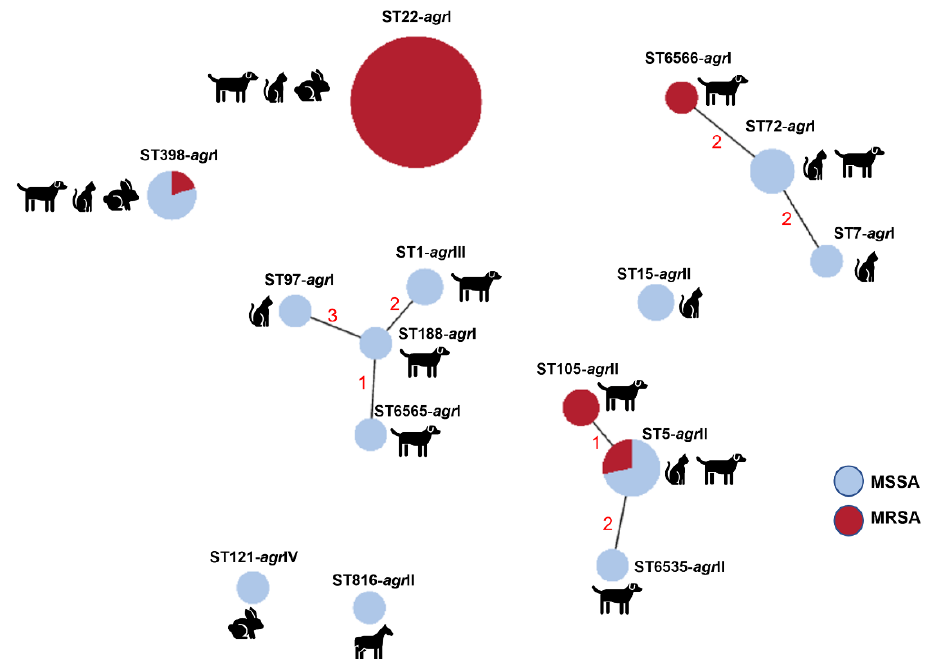
Figure 3. Relationship between clonal lineages, host and methicillin resistance among the 55 SSTI- related S. aureus isolates. The relationship between clonal lineages was estimated using the goeBurst algorithm available at PhyloViz Online. Clonal lineages sharing at least four alleles are linked with solid lines; numbers correspond to the diverging alleles.